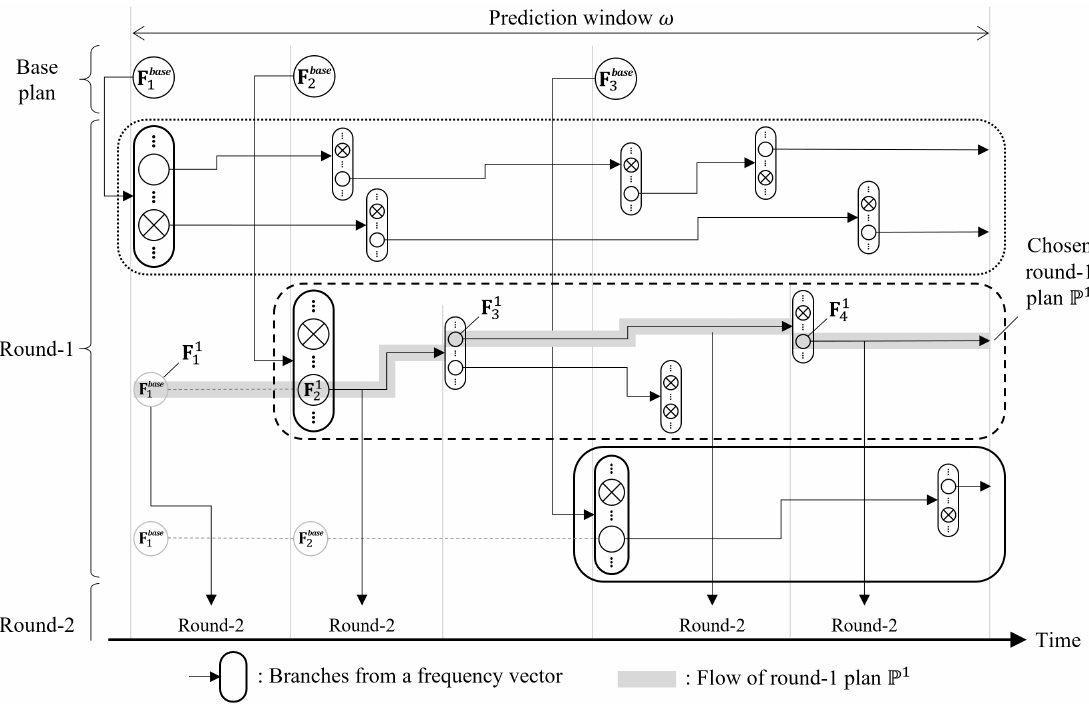
Figure 16. Repeating multi rounds of most-likely neighbor